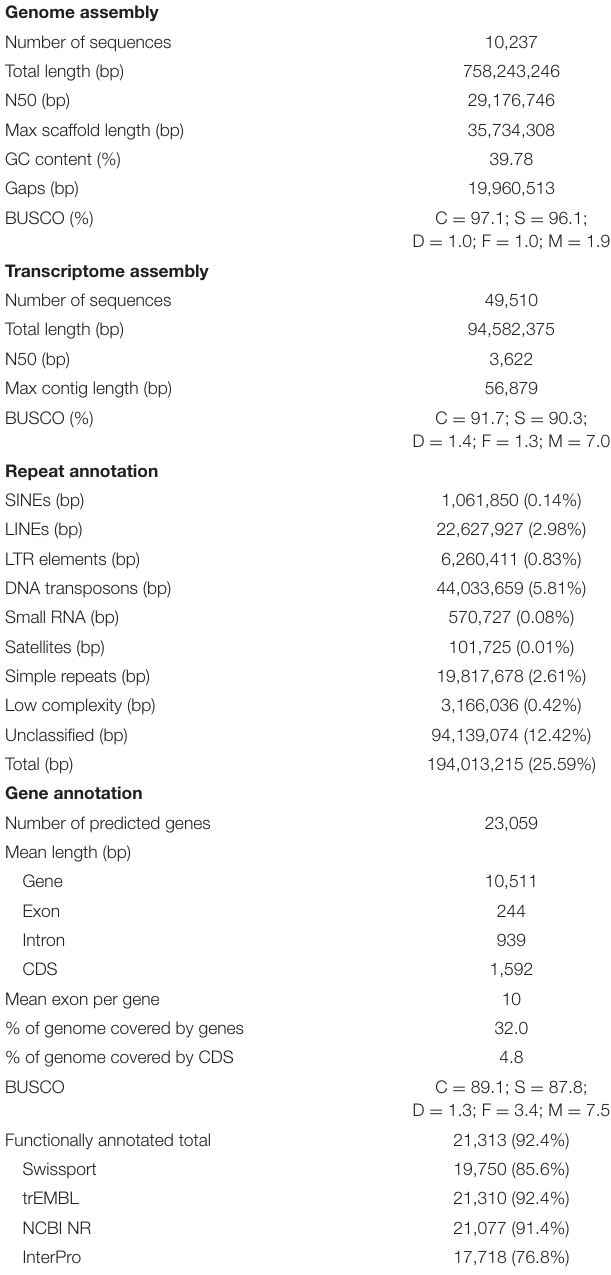
TABLE 1 | Descriptive statistics of kawakawa Euthynnus affinis genome assembly, transcriptome assembly, repetitive DNA annotation, gene prediction, and functional annotation with completeness assessment